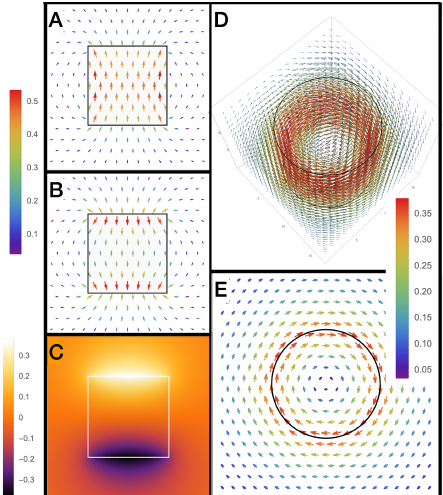
Figure 2. Field and potential plots for a cylindrical dipole with AR = 1. ( A ) 2D vector plot of the nor- (cid:126) D T malized electric flux density at y = 0, in the ( r − z ) plane, calculated from Equations (37) and (38); σ i e (cid:126) E ( B ) 2D vector plot of the normalized electric field (cid:101) at y = 0, in the ( r − z ) plane, calculated from σ i e Equation (34); ( C ) 2D colour density plot of the normalized electric scalar potential (cid:101) V at y = 0, in σ i e the ( r − z ) plane, calculated from Equation (30); ( D ) 3D vector plot of the normalized electric vector (cid:126) C potential, ; ( E ) 2D vector plot of the normalized electric vector potential, at z = 0, in the ( r − φ ) σ i e plane, one can see that the electric vector potential is maximum at the radial boundary where the magnetic current exists.